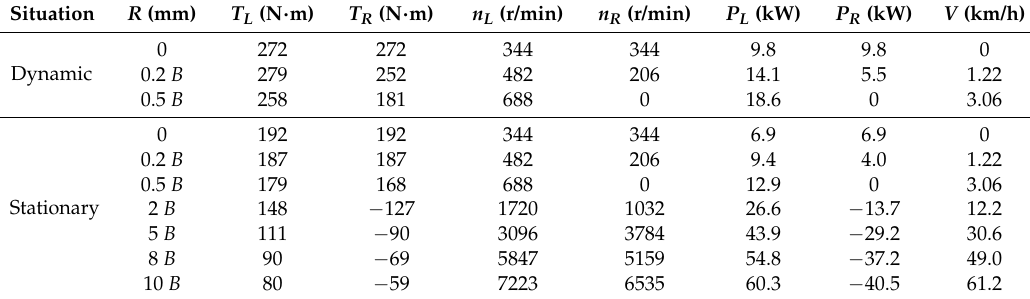
Table 3. Dynamic and stationary steering torque and power required by two motors.